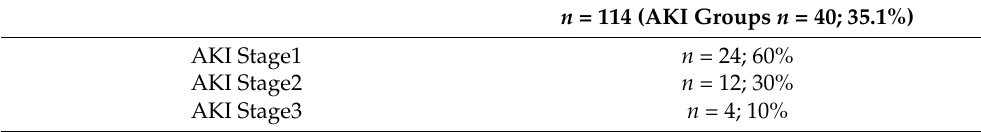
Table 1. KDIGO AKI classification.